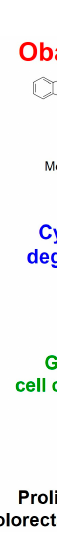
Figure 5. Schematic model depicting the mechanisms of action underlying obatoclax-induced antiproliferation. Obatoclax targets cyclin D1 for proteasome-mediated degradation to downregulate cyclin D1, leading to delayed G 1 -phase cell cycle progression, and the consequent inhibition of cell proliferation in a panel of human colorectal cancer cell lines.